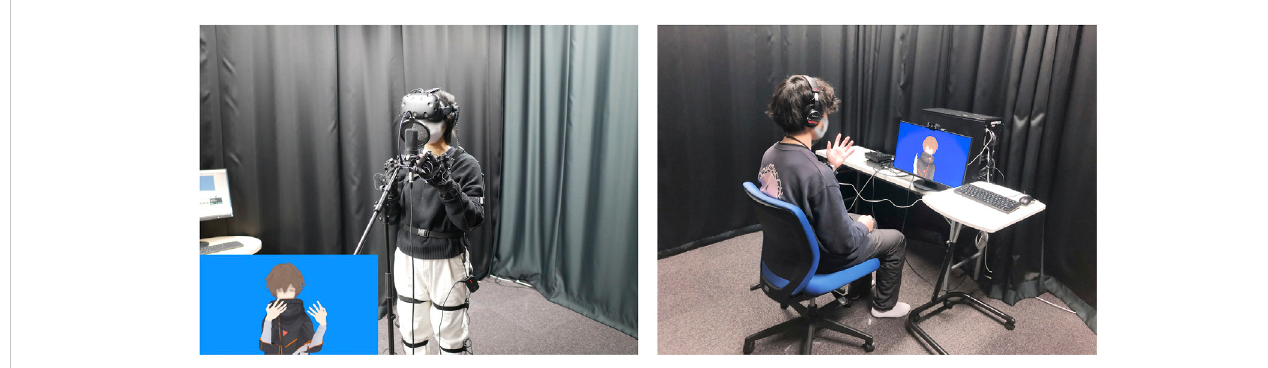
FIGURE 1 Experimental environment in IVR (left), and experimental environment in 2D